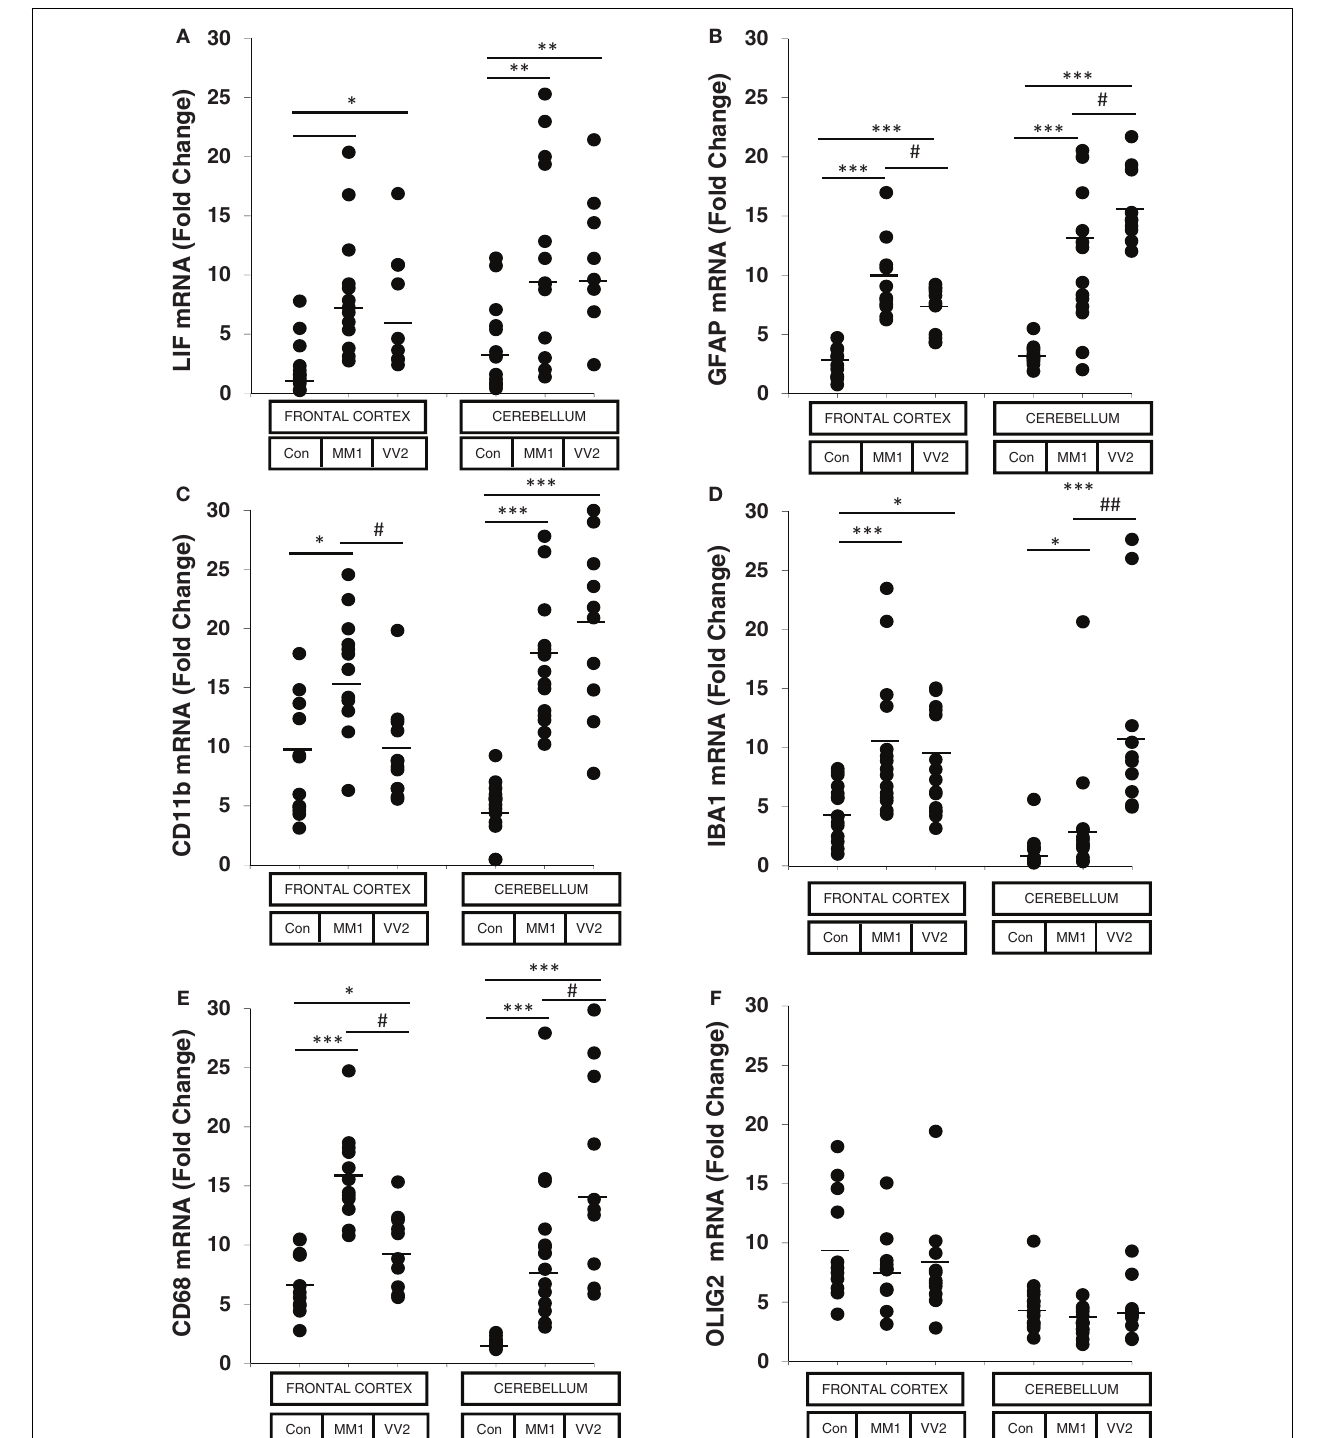
Frontal cortex: control (Con, n = 15), MM1 ( n = 15),VV2 ( n = 15); cerebellum: control (Con, n = 15), MM1 ( n = 15),VV2 ( n = 10). Data are represented as the mean SEM. * p < 0.05, ** p < 0.01, *** p < 0.001 sCJD compared with control cases; # p < 0.05, ## p < 0.01 sCJDVV2compared with sCJD MM1 cases (Tukey’s post hoc